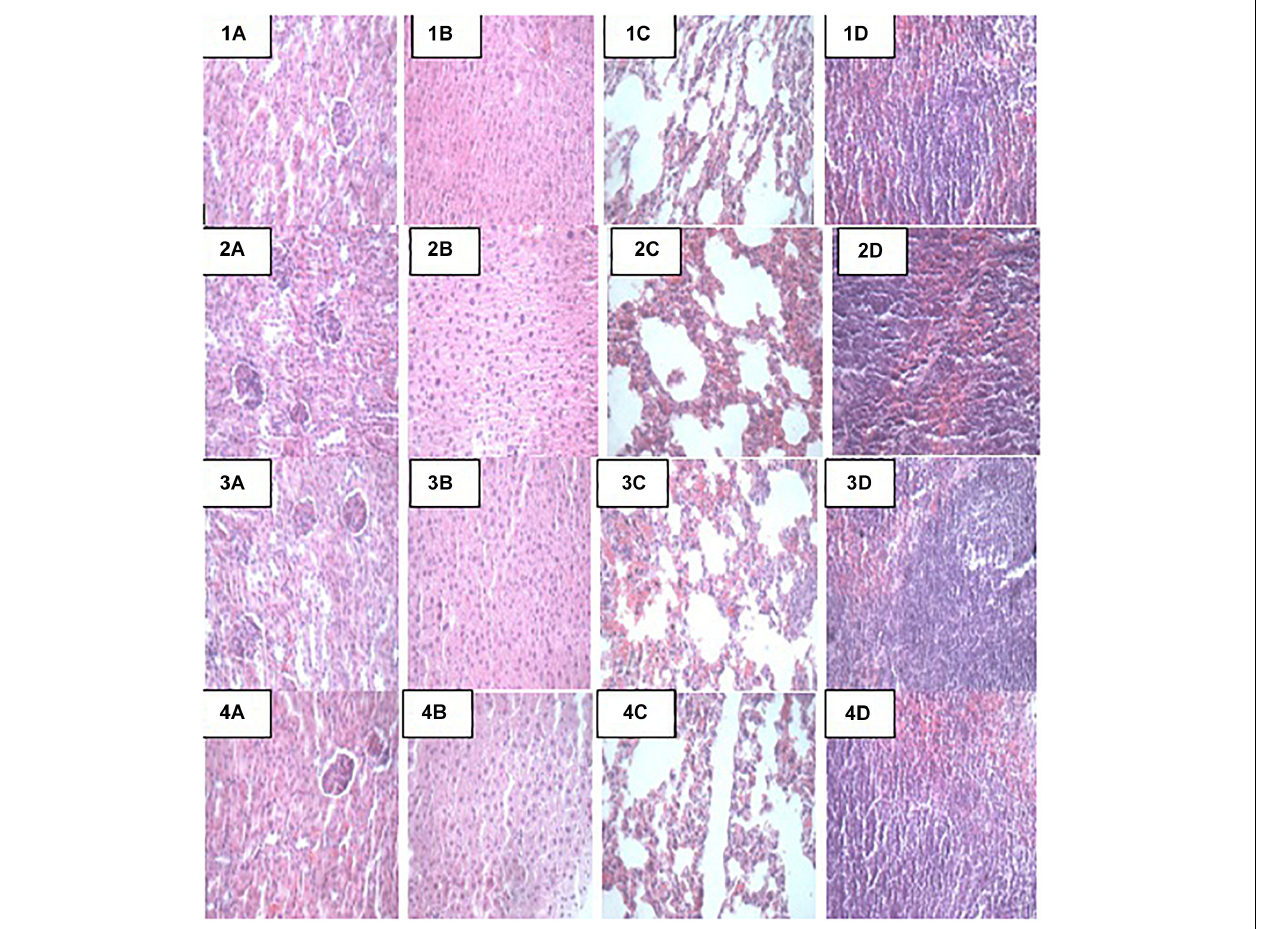
FIGURE 1 | Representative photomicrographs of organs of mice fed Control, T ST , T LB , and T STLB diets 1A–1D : Control (Kidney, liver, lung, and spleen, respectively), 2A–2D : T ST (Kidney, liver, lung, and spleen, respectively), 3A–3D : T LB (Kidney, liver, lung, and spleen, respectively), and 4A–4D : T STLB (Kidney, liver, lung, and spleen,